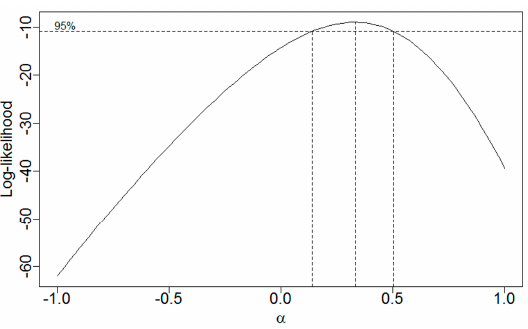
Figure 6. Plot of the log-likelihood function as a function of λ for the variable transformation y ′ = y α . Table 5. Results of the OLS regression of Model 2 on the test data set.